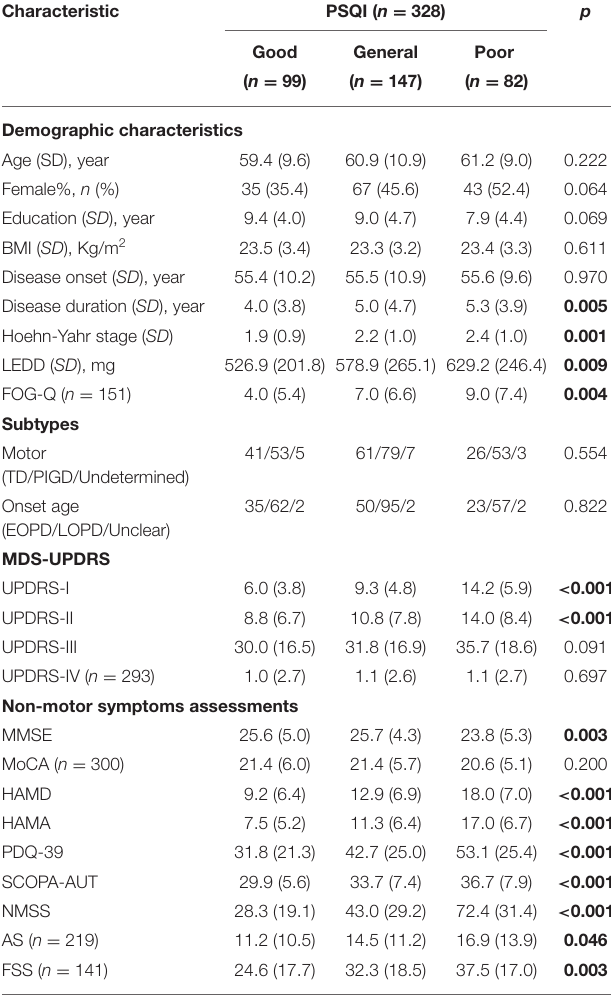
TABLE 1 | The characteristics of